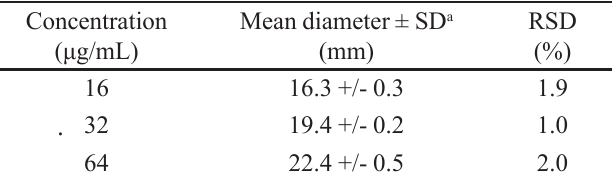
TABLE I - Mean diameters of the growth inhibition zones obtained for the CFTX standard curve for 16, 32 and 64 μg/mL